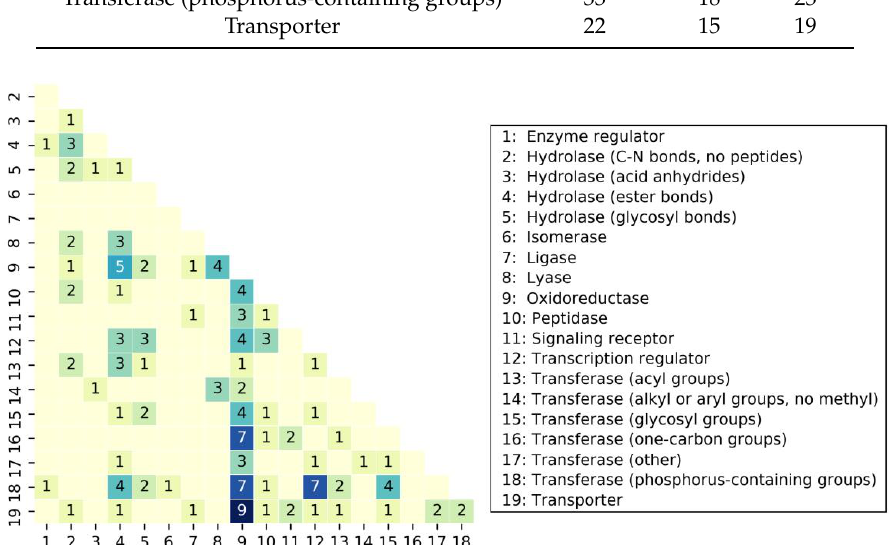
Figure 2. Shared MCLs. The heatmap shows the number of MCLs shared by different protein